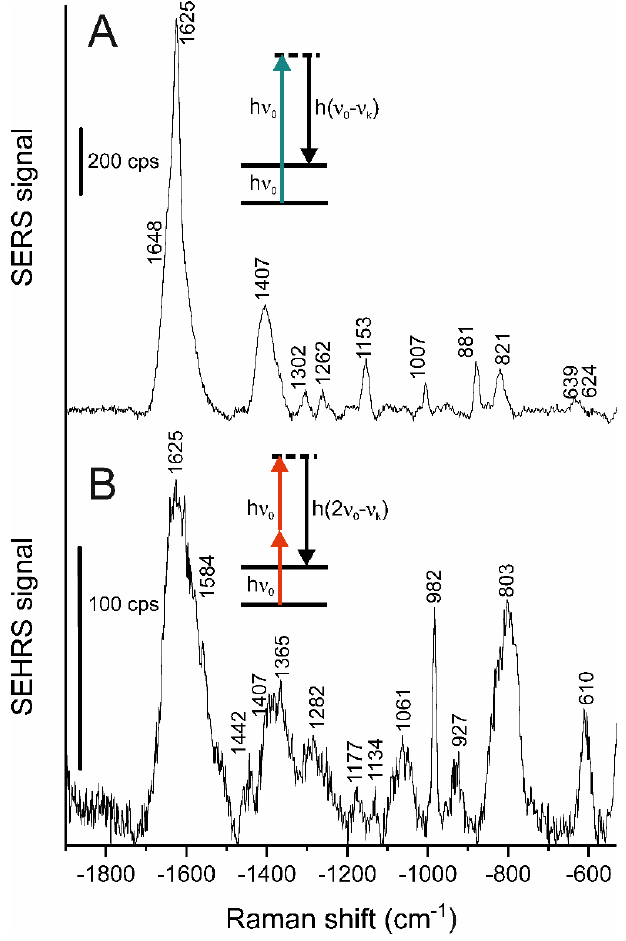
Figure 7. ( A ) SERS and ( B ) SEHRS spectrum of a sample containing silver nanoparticles, MgSO 4 , and 10 − 5 M acrylamide, indicating the formation of polyacrylamide in the acrylamide containing samples. Excitation conditions: ( A ) 532 nm, 1.9 × 10 27 photons cm − 2 s − 1 ( B ) 1064 nm, 3.4 × 10 28 photons cm − 2 s − 1 . Acquisition time: ( A ) 1 s, ( B ) 10 s, average of 67 spectra. The insets in ( A ) and ( B ) depict the